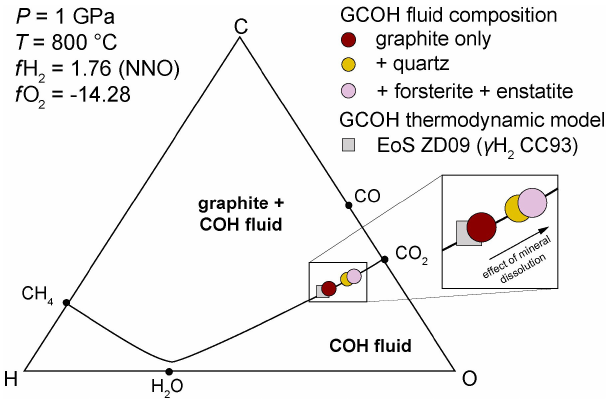
Figure 2. Measured COH volatile composition of graphite- saturated fluids interacting with silicates at 1GPa and 800 ◦ C and f H 2 buffered by NNO, modified from Tumiati et al. (2017). The volatile composition of fluid was measured through quadrupole mass spectrometry (Tiraboschi et al., 2016) in equilibrium with graphite only, graphite + quartz, and graphite + forsterite + en- statite. In the diagram is also reported the graphite saturation sur- face (solid black line) and the volatile fluid composition predicted by the EoS of Zhang and Duan (2009) using the H 2 fugacity co- efficient of Connolly and Cesare (1993). In the zoomed-in box the effect of silicate dissolution is highlighted. Oxygen and hydrogen fugacity values are reported as log f O 2 and log f H 2